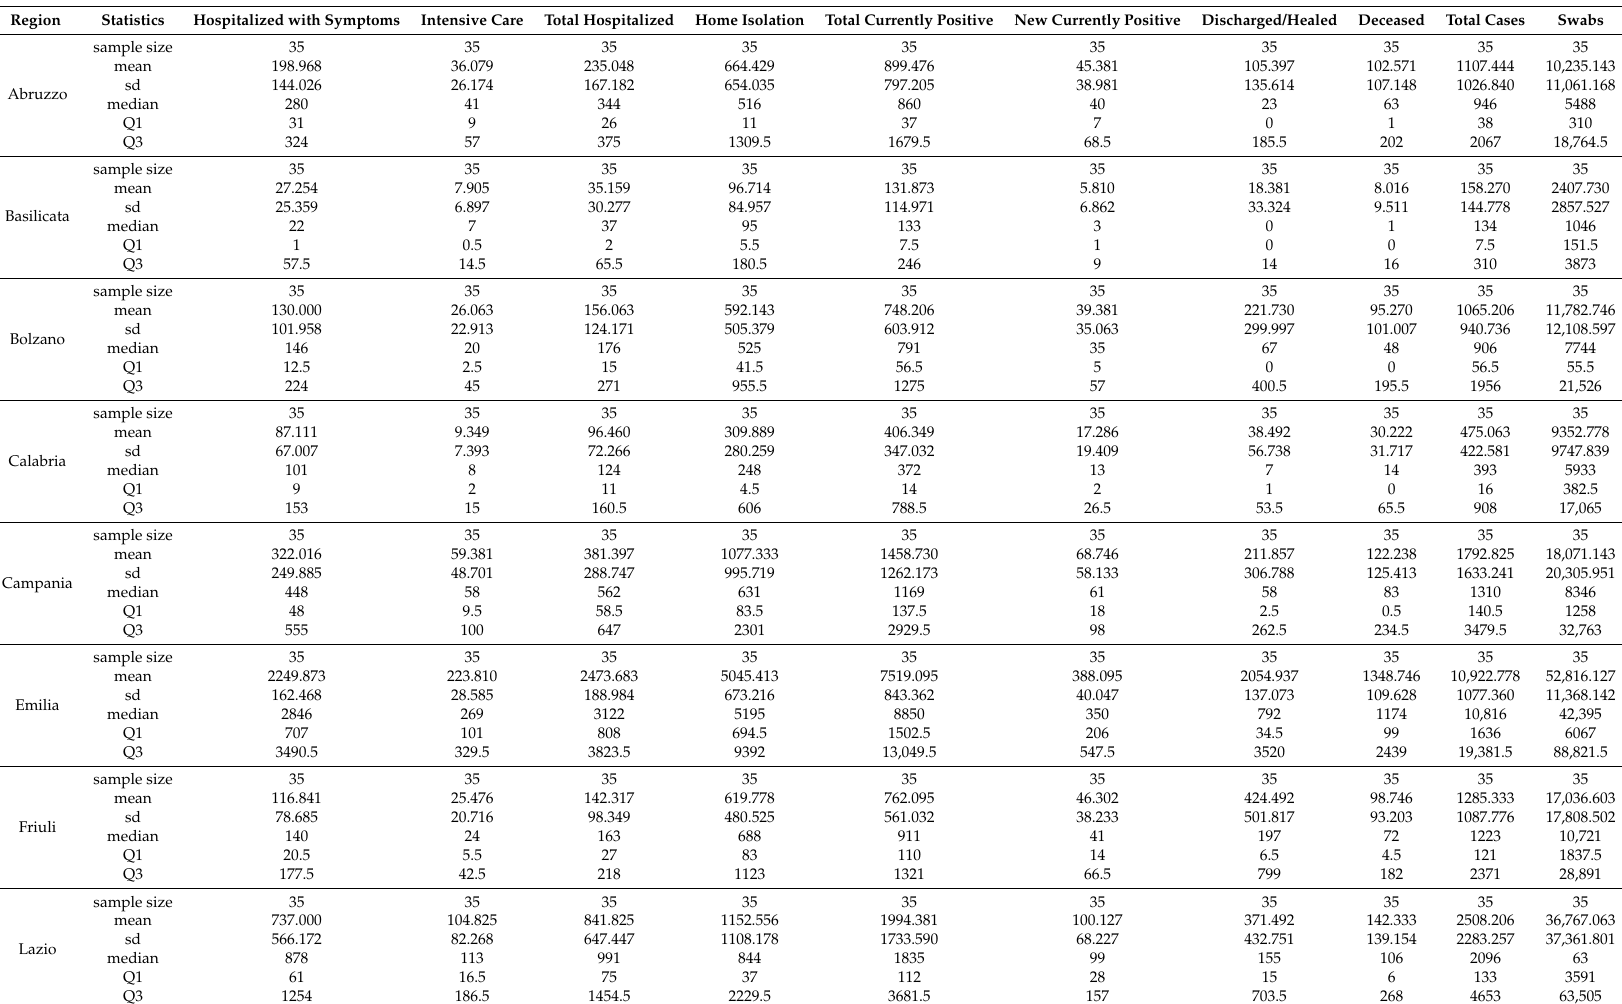
Table 1. Descriptive statistics for all regions in the study